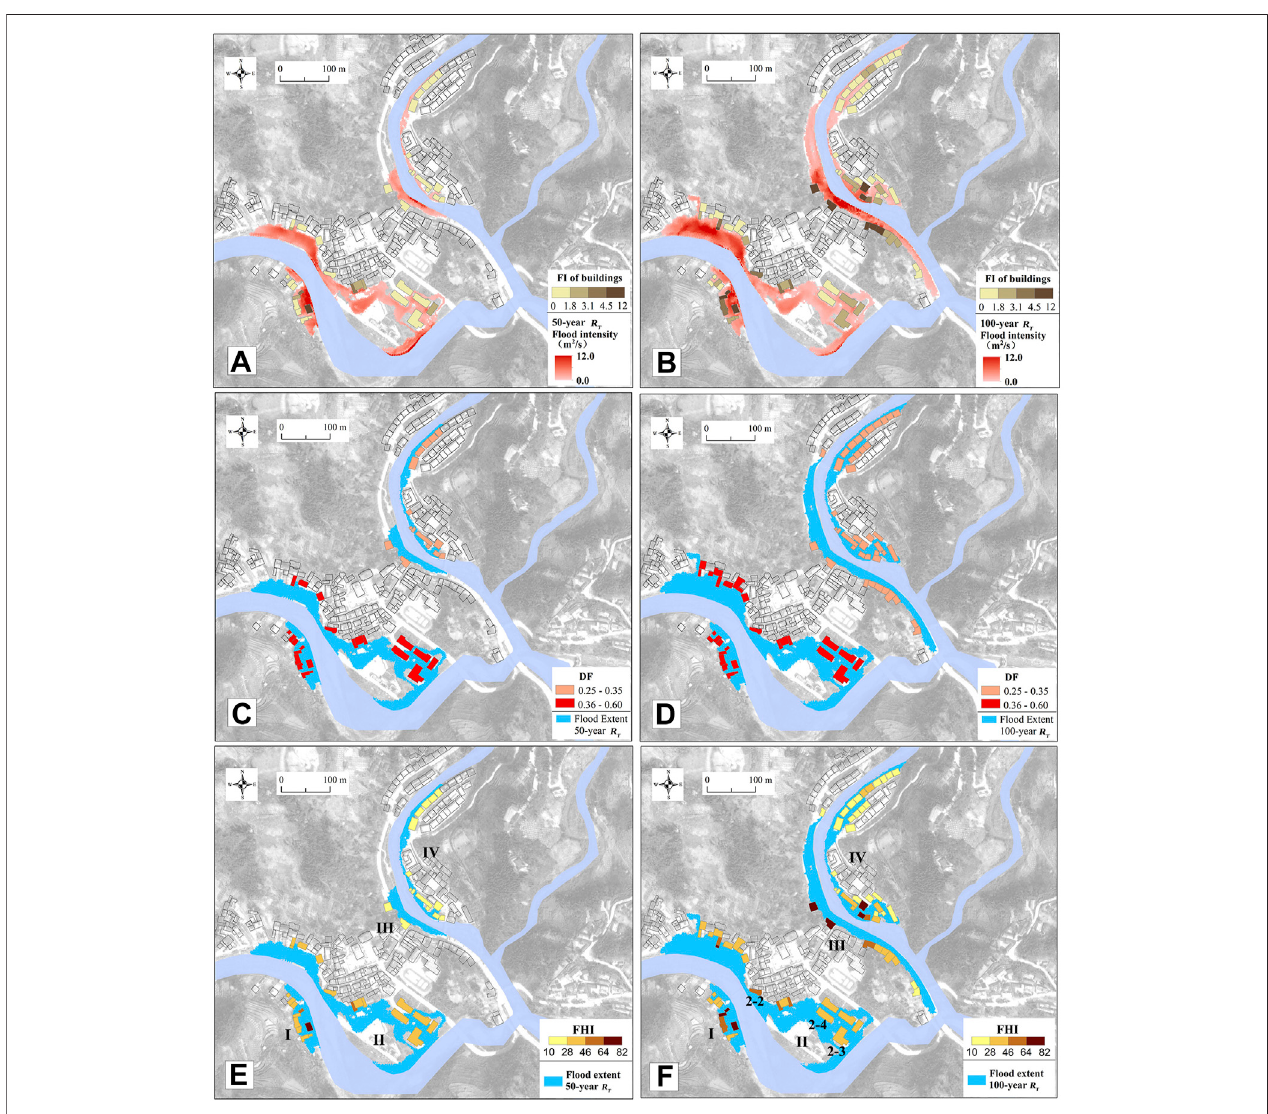
FIGURE 9 | Flood hazard results. (A) and (B) are maximum FI in fl ood scenarios with 50-year and 100-year R T , (C) and (D) are DF in fl ood scenarios with 50-year and 100-year R T , and (E) and (F) are distribution of FHI in fl ood scenarios with 50-year and 100-year R T .